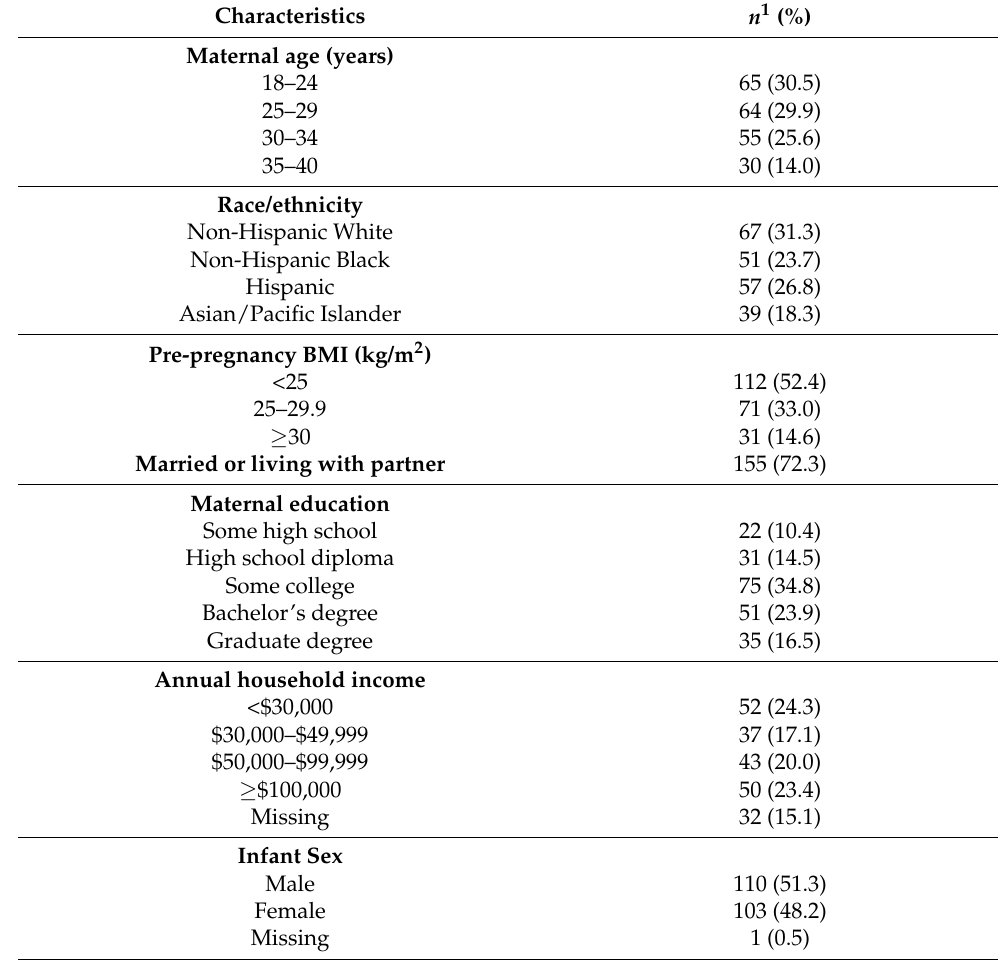
Table 1. Weighted demographic characteristics of study participants at enrollment ( n =